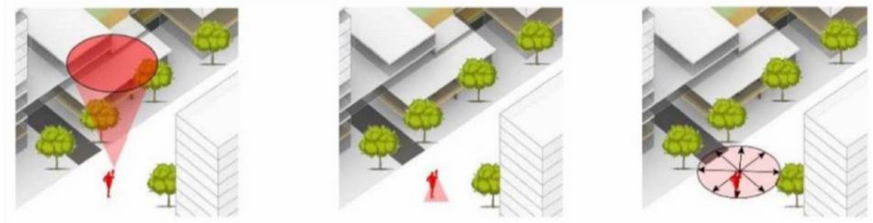
Figure 5. Measurement method of ground windows.